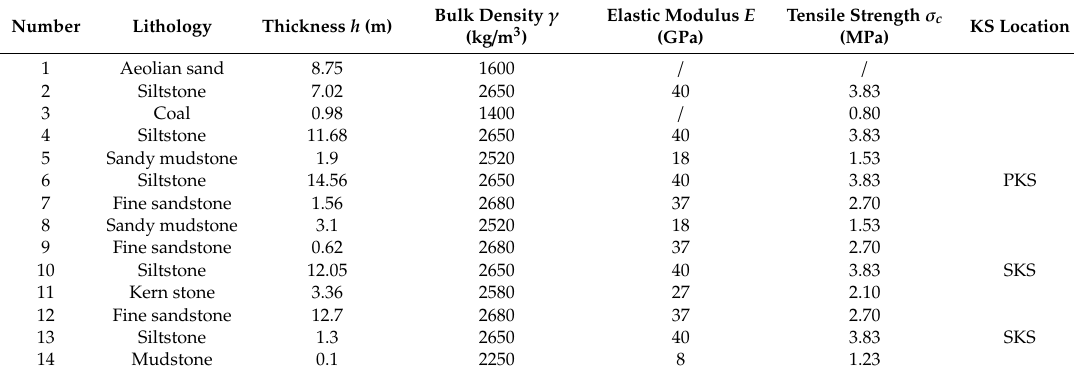
Table 2. Mechanical parameters of overlying strata and KS